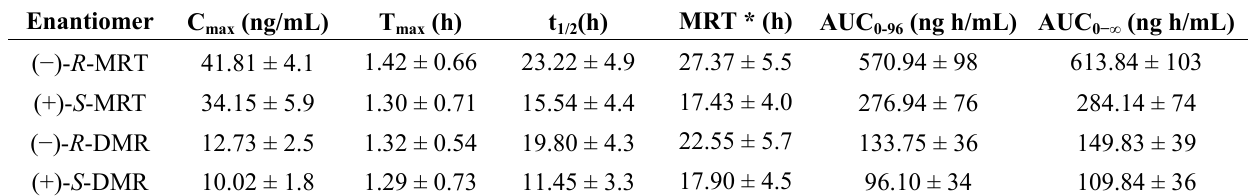
Table 6. Pharmacokinetic parameters of the enantiomers of MRT and DMR after oral administration of rac - MRT 30 mg to 12 healthy